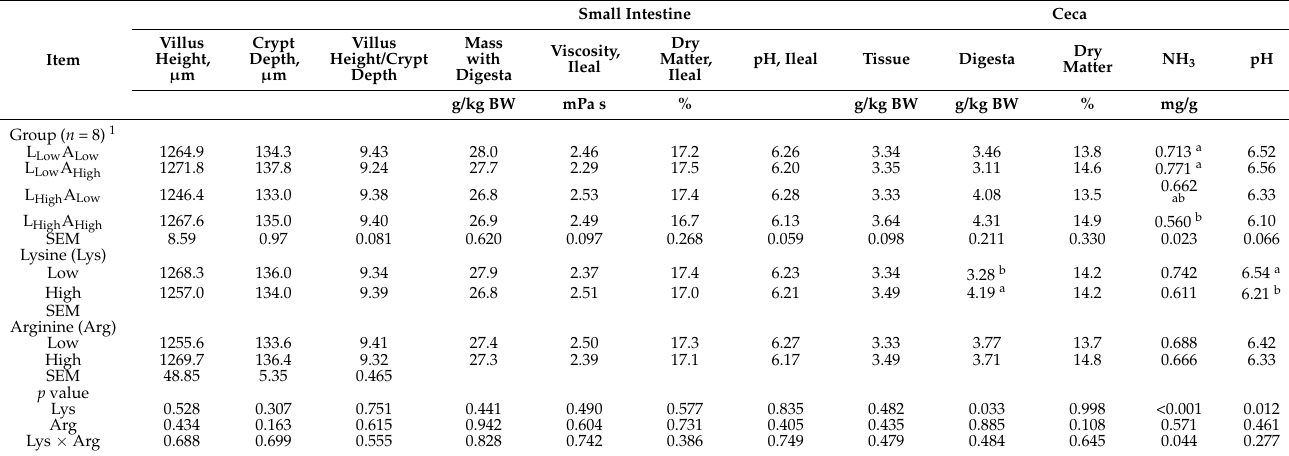
Table 3. Parameters of small intestinal and cecal physiology in experimental